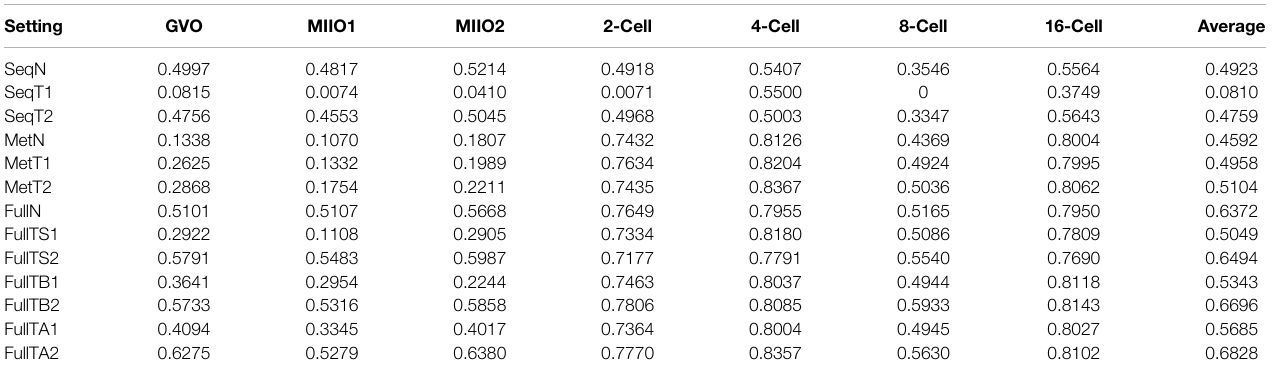
TABLE 3 | F1 score of models trained for target pro fi les in varying transfer settings.